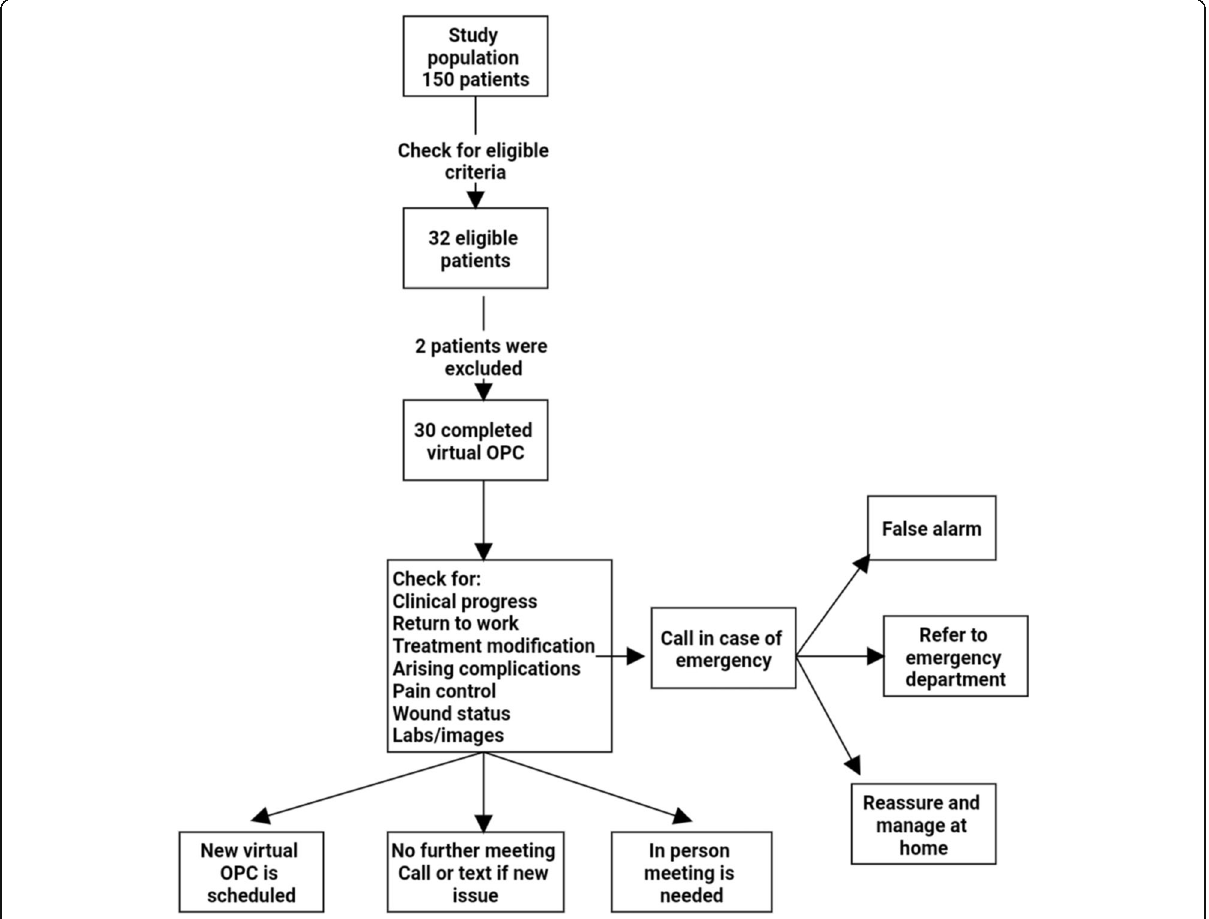
Fig. 1 Flow chart of